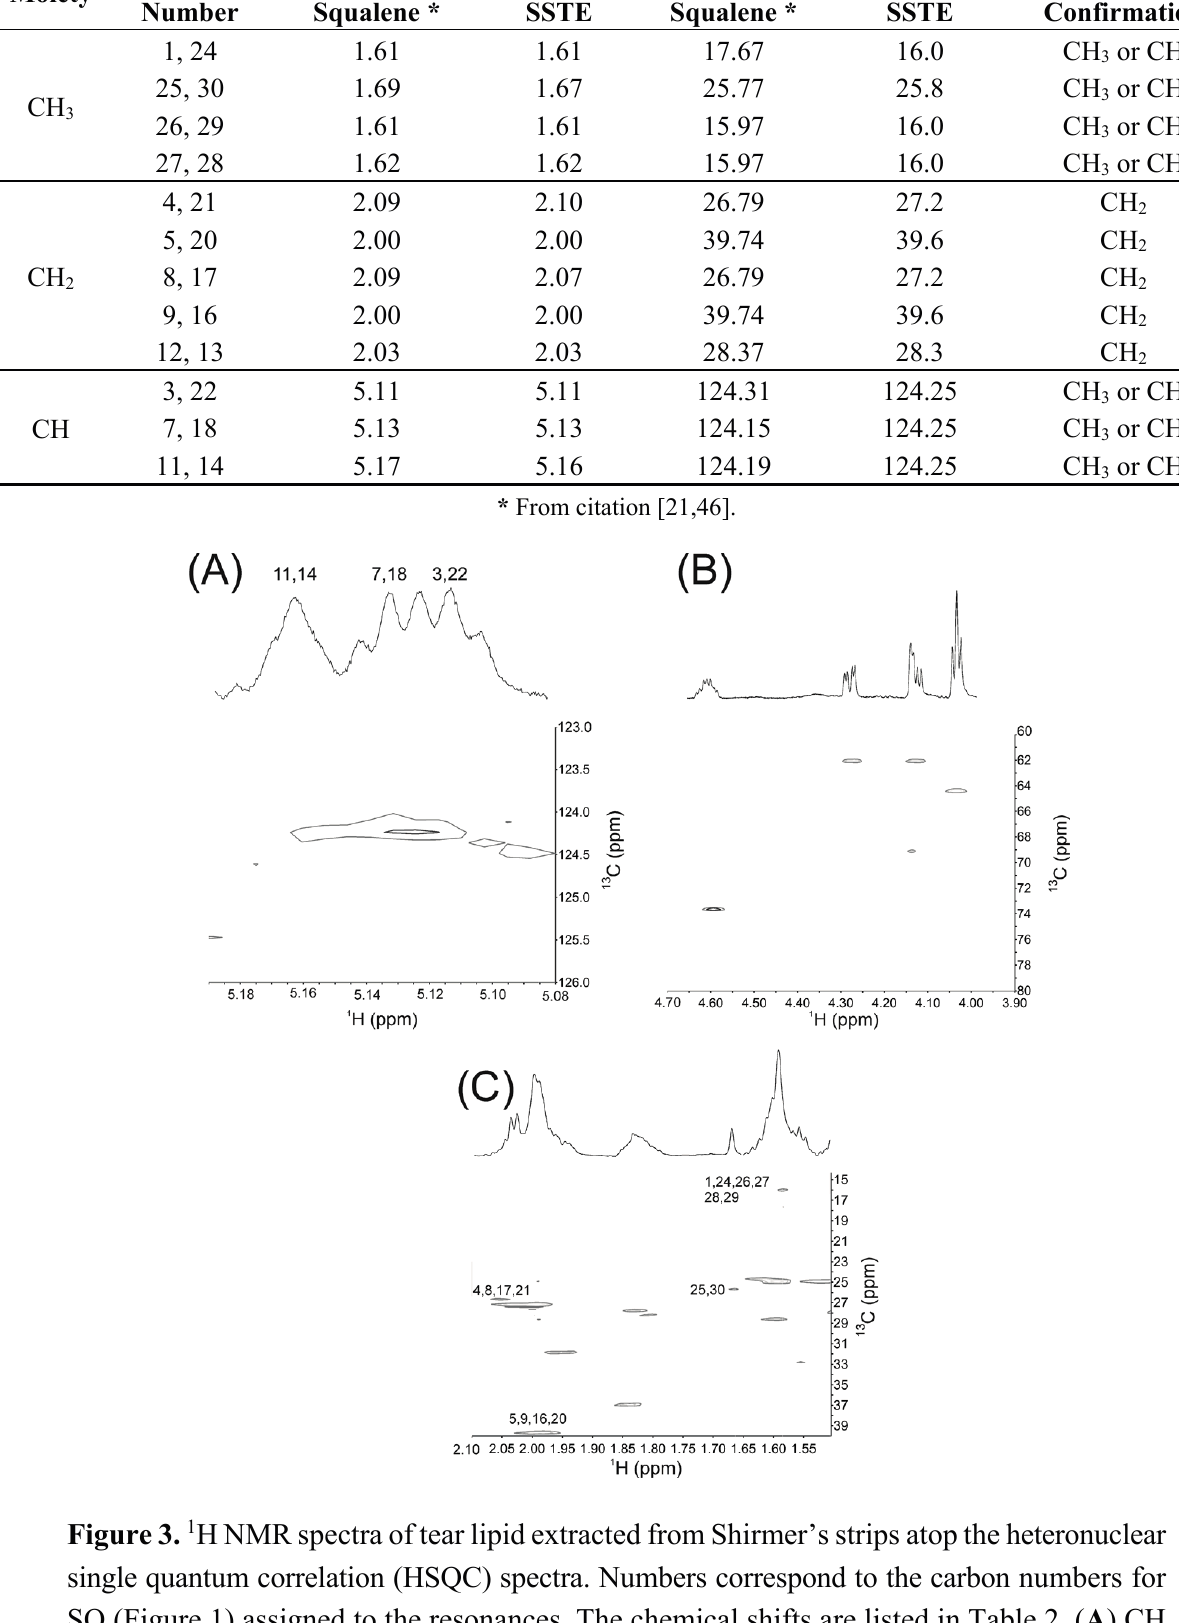
Table 2. Confirmation of 1 H and 13 C NMR resonance assignments for squalene and SSTE. Moiety